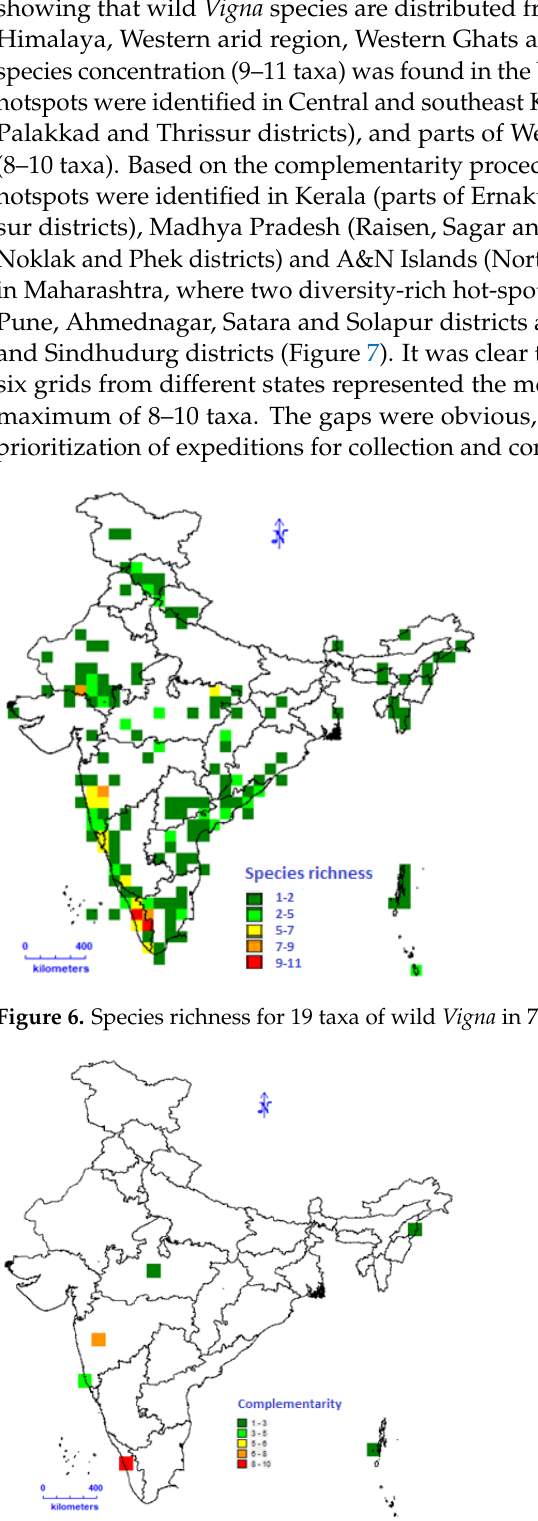
Figure 7. Diversity-rich hotspots for 19 taxa of wild Vigna identi fi ed using a complementarity anal- ysis.